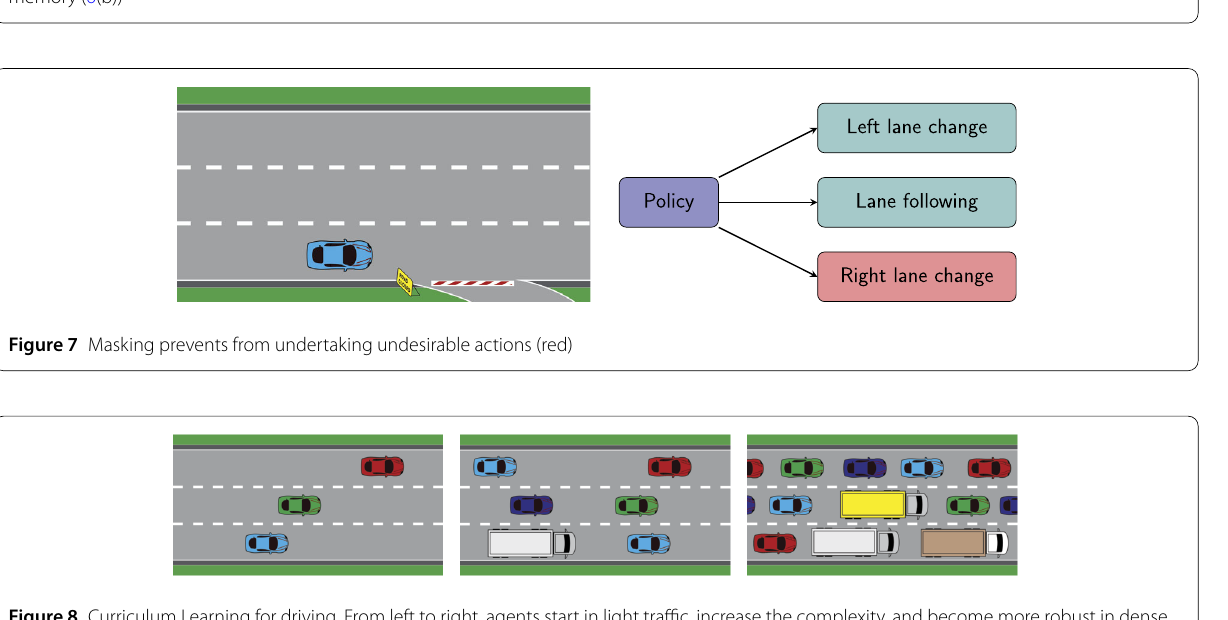
Figure 8 Curriculum Learning for driving. From left to right, agents start in light traffic, increase the complexity, and become more robust in dense